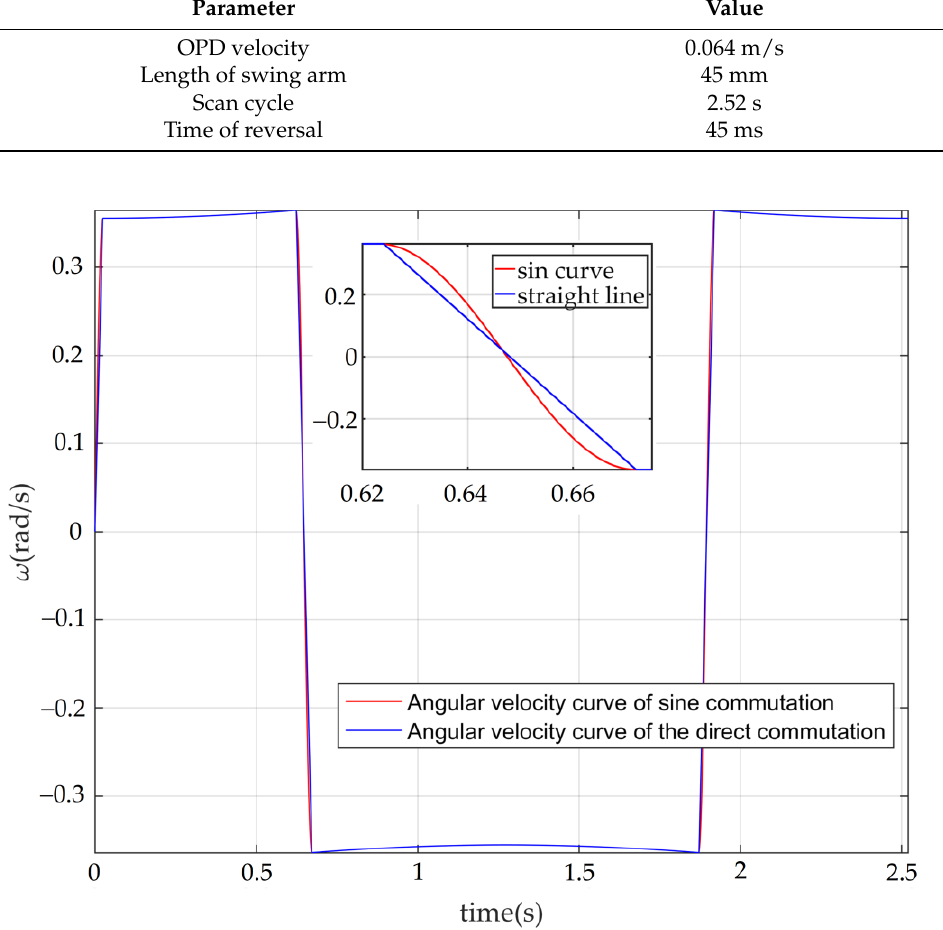
Figure 5. The angular velocity curve of the RT VCM.